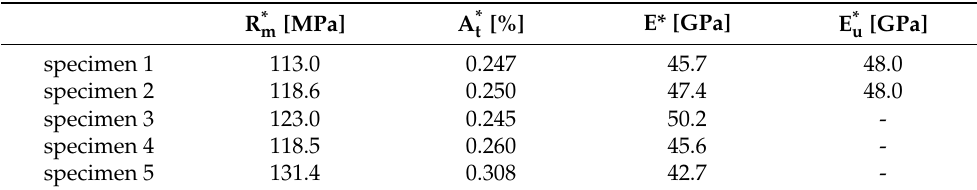
Table 2. Mechanical properties of the five tested specimen. R ∗ m —ultimate tensile strength; A ∗ t —